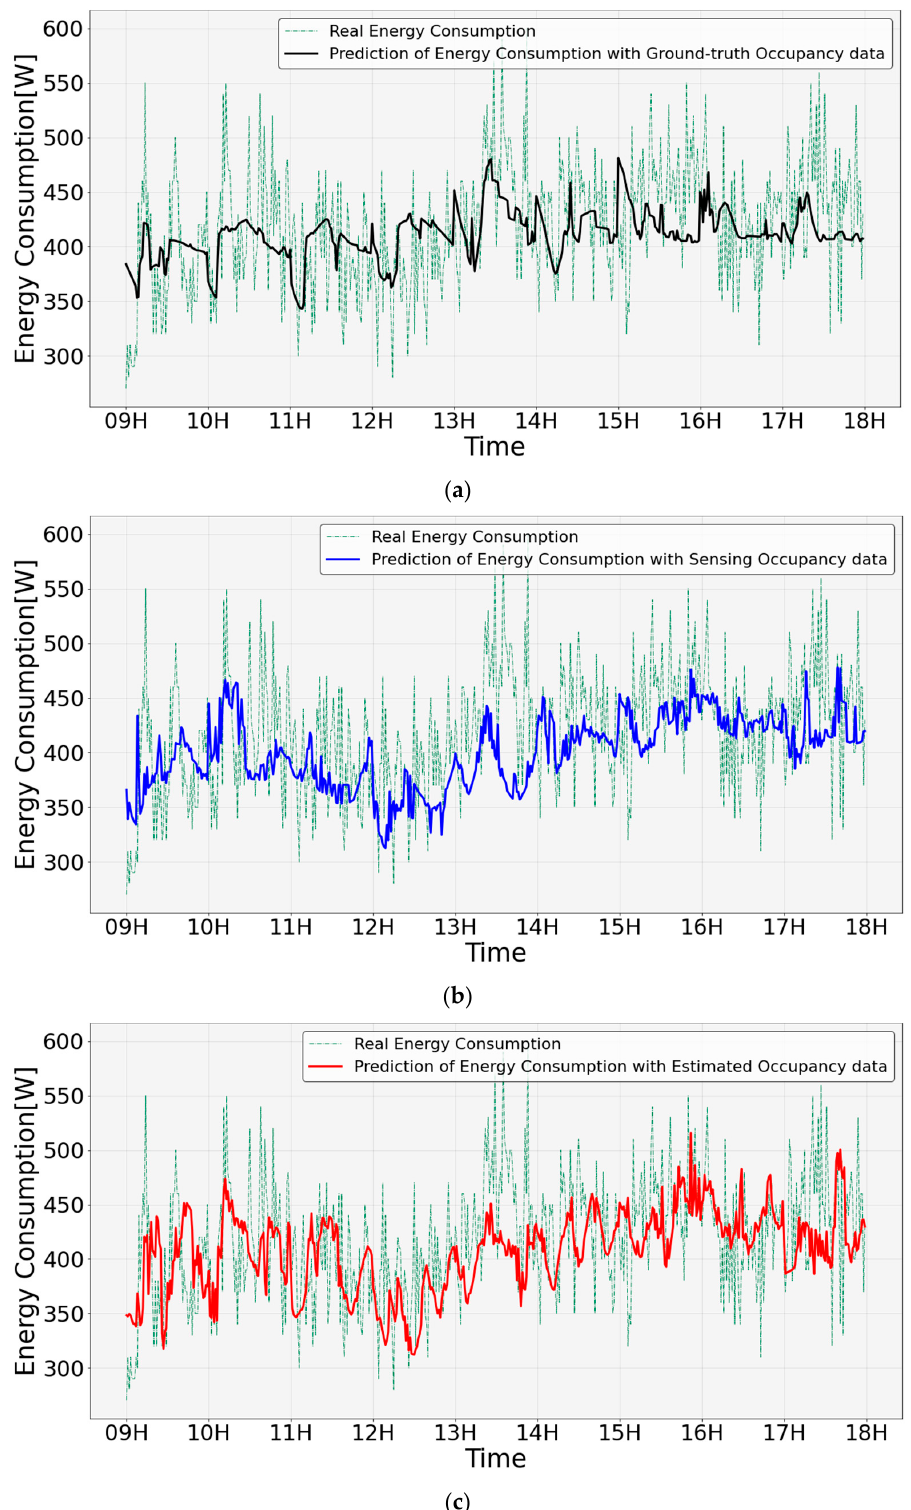
Figure 16. Prediction result of energy consumption based on the occupancy using deep learning: ( a ) prediction of energy consumption with ground-truth data; ( b ) prediction of energy consumption with sensing data; ( c ) prediction of energy consumption with estimated